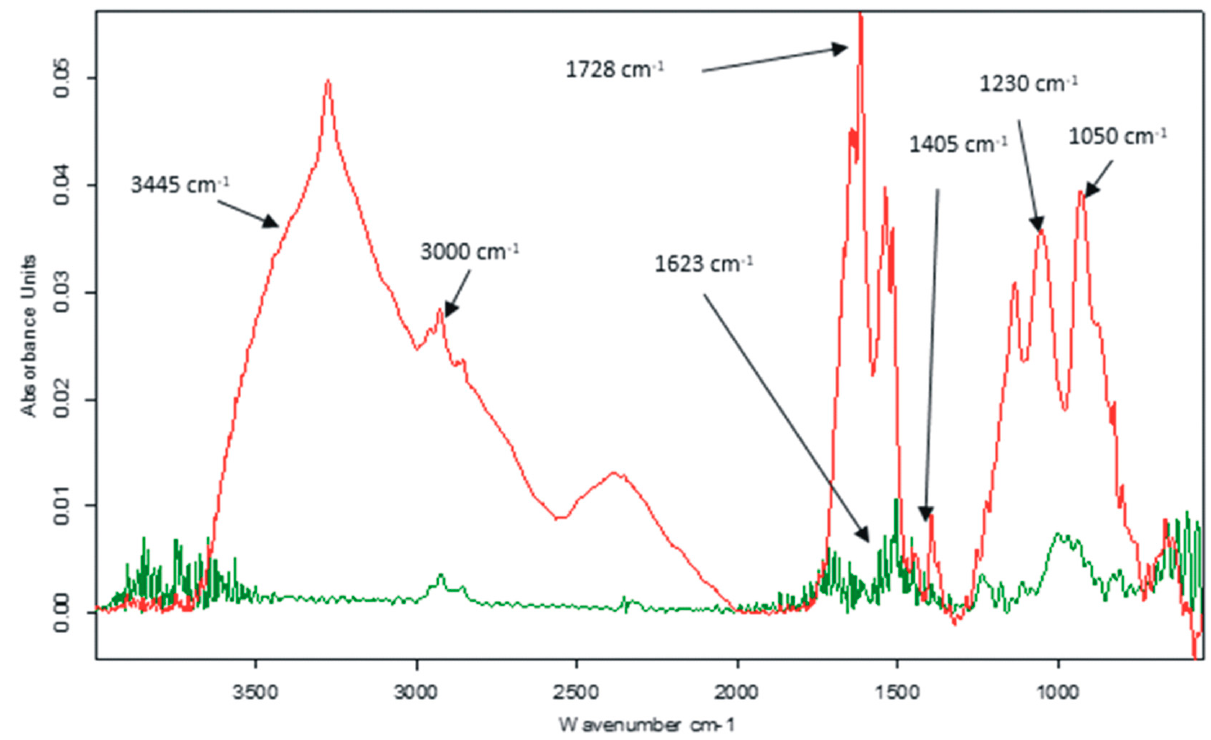
Figure 4. FTIR spectra for GO/SPCE (green line) and GO-Peptide/SPCE (red line).